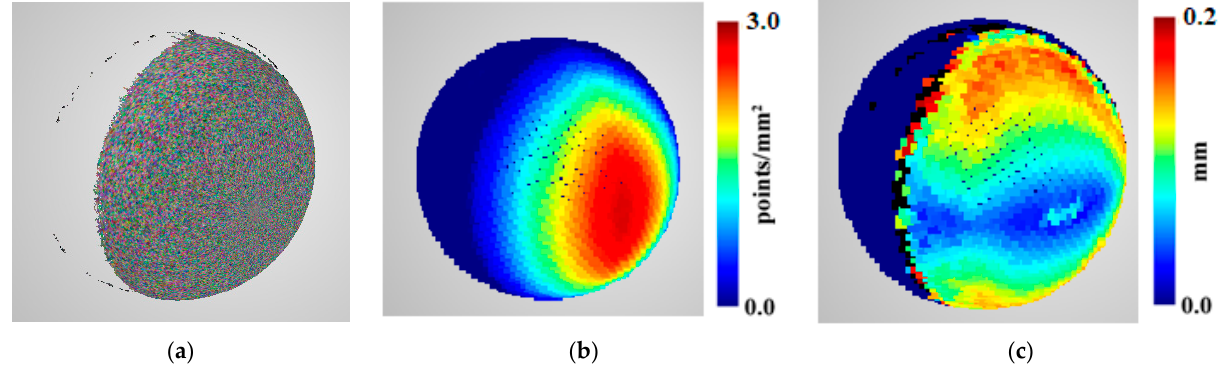
Figure 3. Example ( a ) sphere reconstruction from a two-camera scenario; ( b ) the results of density computation (points/mm 2 ); ( c ) accuracy evaluation (mm).